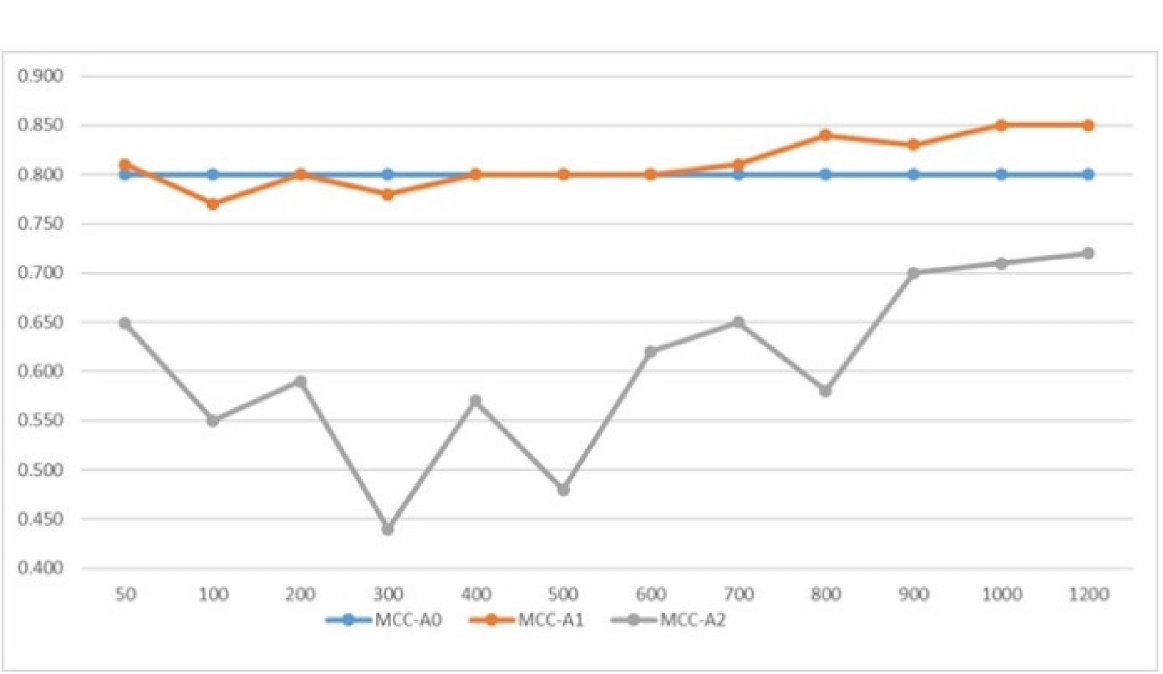
Figure 7. Solder dataset: MCC for A0, A1, and